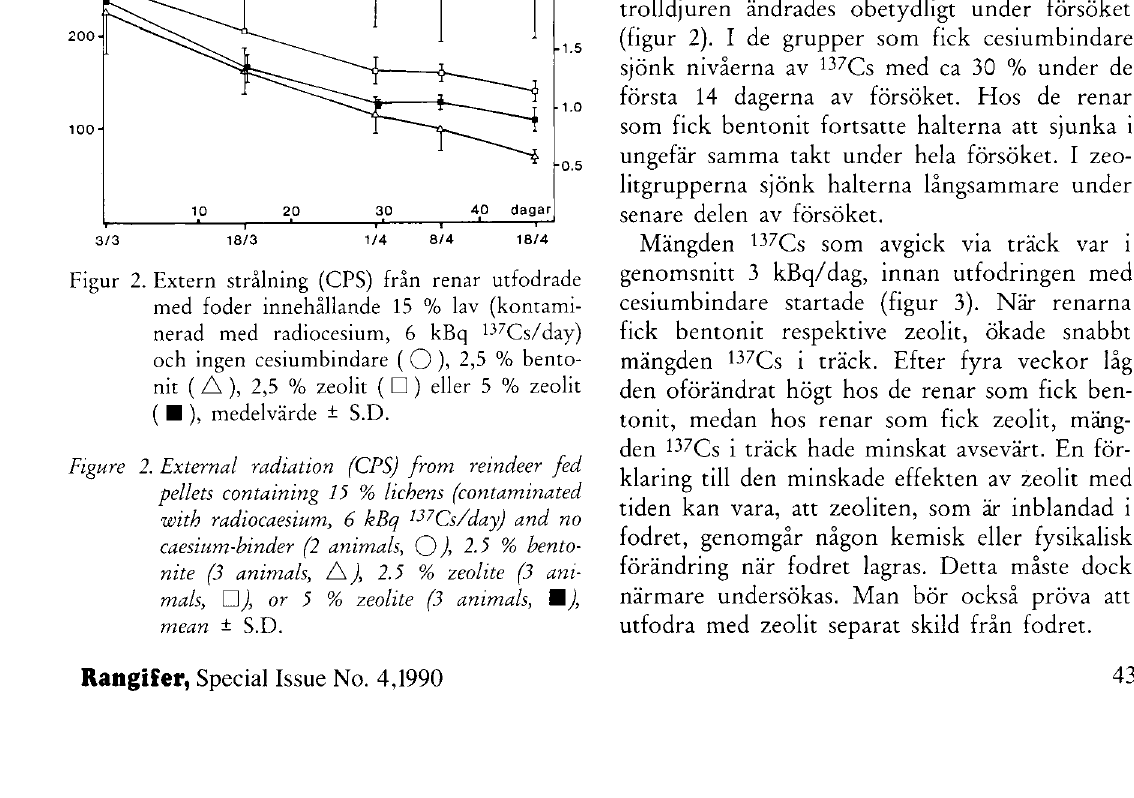
Figur 2. Extern straining (CPS) fran renar utfodrade med foder innehallande 15 % lav (kontami- nerad med radiocesium, 6 kBq 137 Cs/day) och ingen cesiumbindare ( O ), 2,5 % bento nit ( A ), 2,5 % zeolit ( • ) eller 5 % zeolit